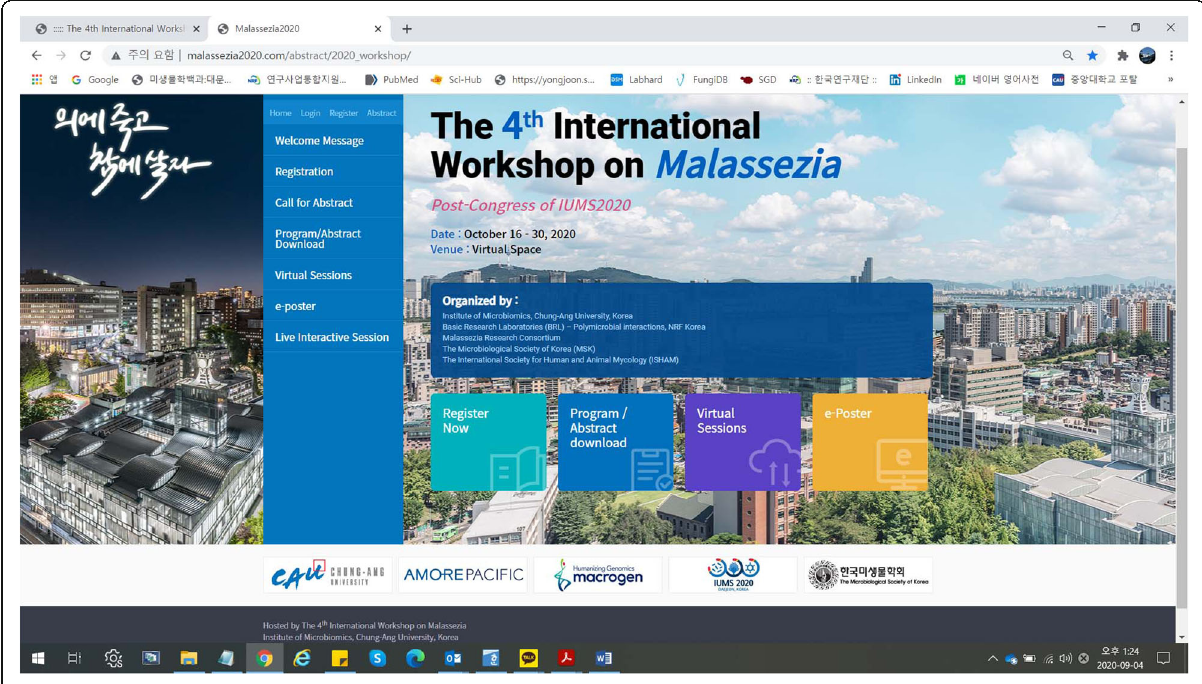
Fig. 18 Website of the 4th International Malassezia